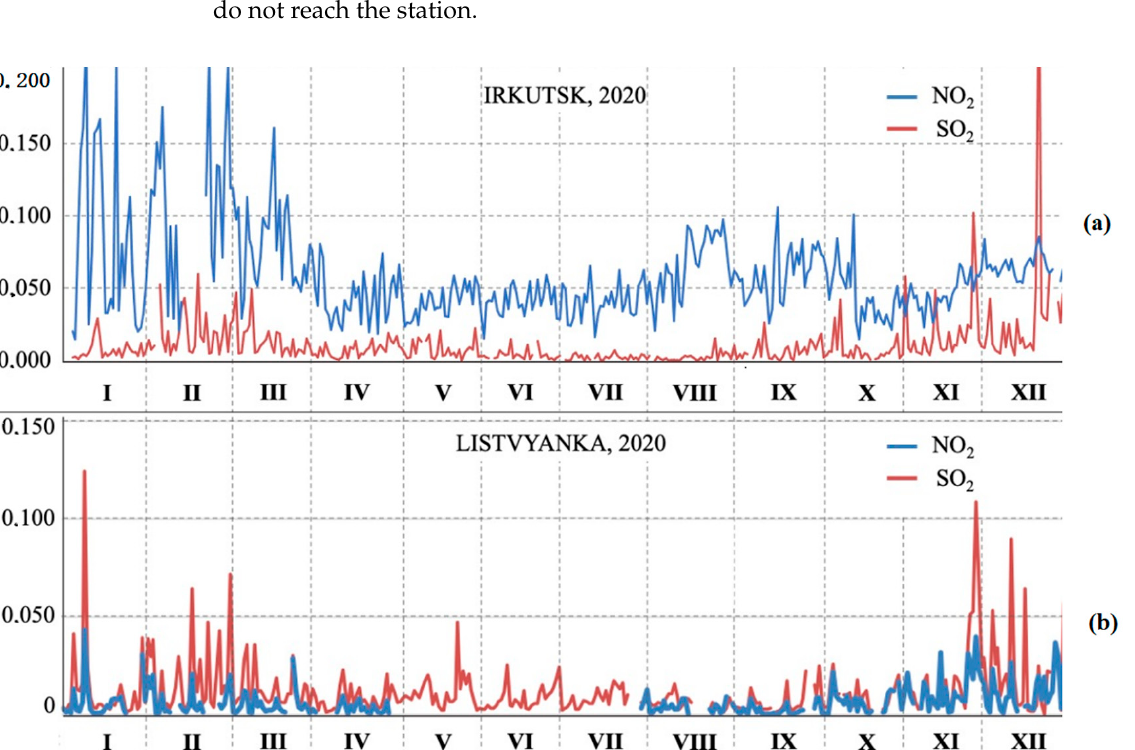
Figure 2. The most typical synoptic situation for air mass transport in the winter season (10 Decem- ber 2020, 00:00 UTC) ( a ); forward air mass trajectories from Angarsk, Irkutsk, and Shelekhov in 2020 ( b ).